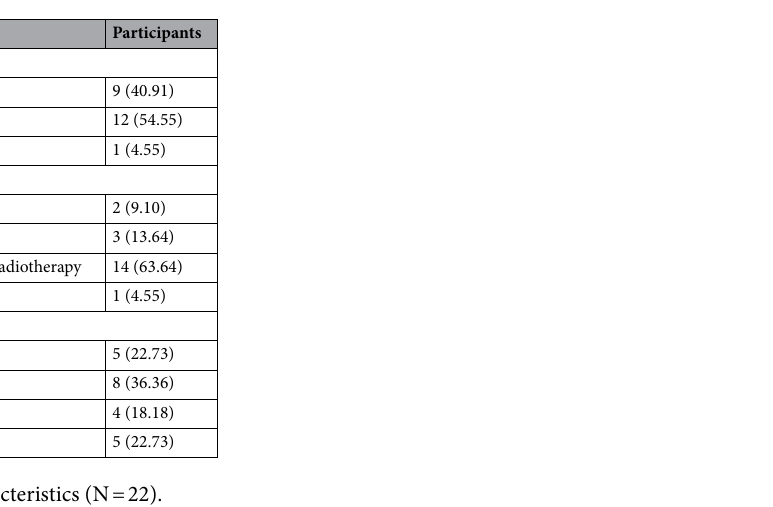
Table 4. Clinical characteristics (N =